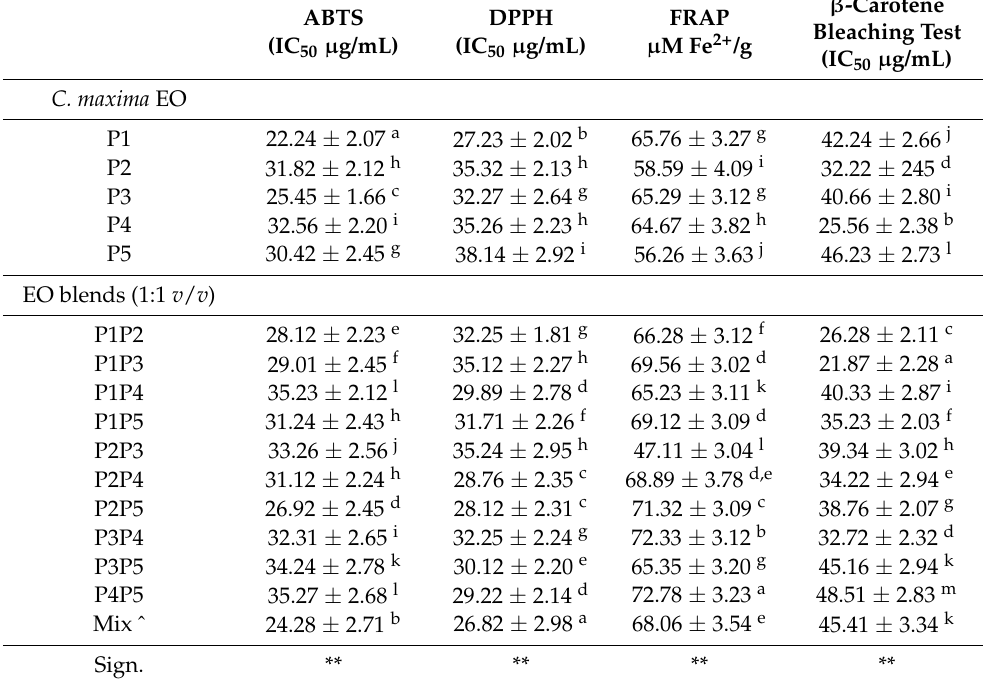
Table 3. Antioxidant activities of C. maxima cultivar EOs and their